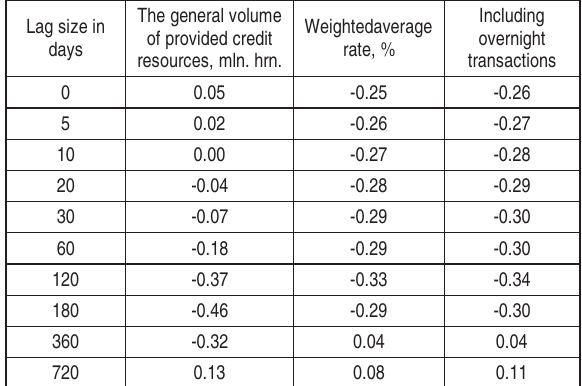
Table 5. Analysis of Ukrainian stock market reactions to the changes of crediting parameters of NBU (daily data) with the use of lags for PFTS index